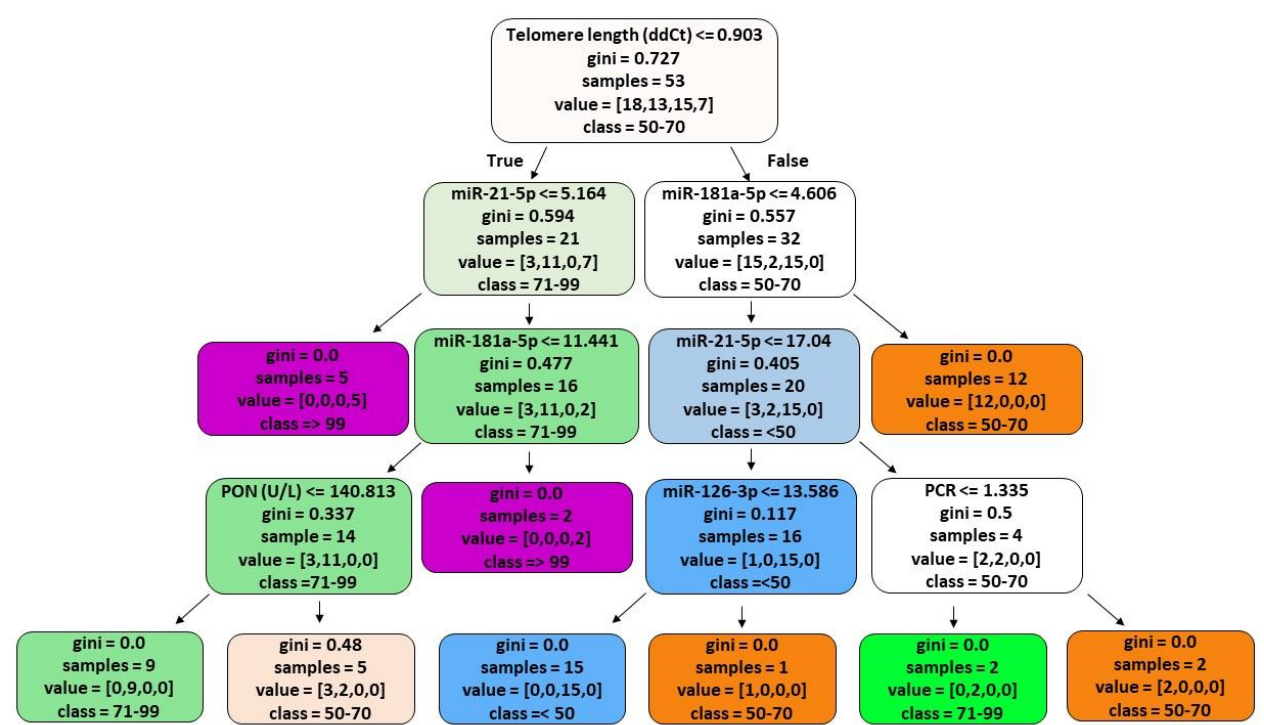
Figure 4. Figure shows the machine learning results. For the interpretation of the decision tree, it is necessary to know that each node of a decision tree contains a condition. This condition can be true or false. If the condition is true, we descend to the next left node. If the condition is false, we descend to the next right node. The different colors represent the age groups (light blue < 50, orange 50–70, green 71–99, pink/lilac > 99 years).